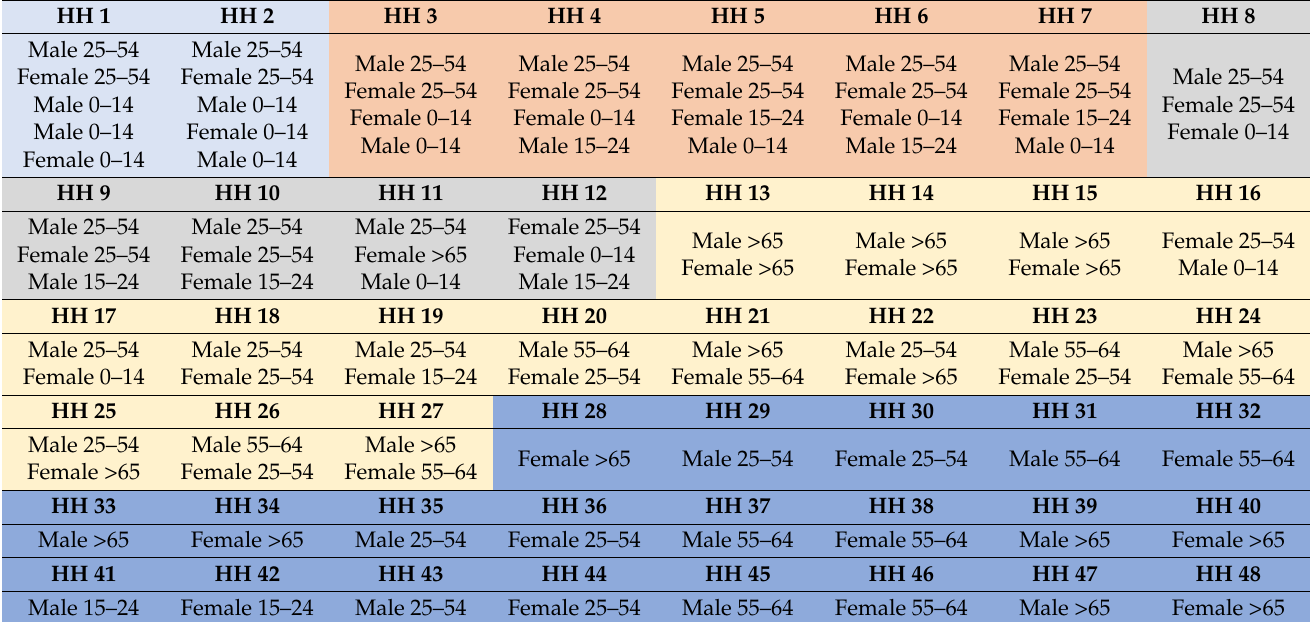
Figure A2. CAGR for Scenario 4 assuming a linear annual growth of the price of electricity for households of 2% of the initial price. Table A1. Composition by gender and age bracket of the inhabitants in the 48 HH (HouseHolds) in the district.